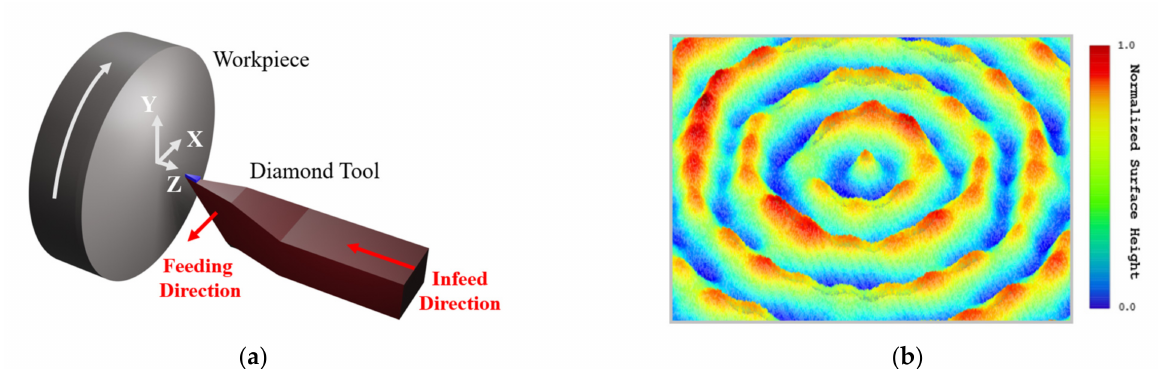
Figure 1. ( a ) On-axis diamond turning visualization. The workpiece is rotated at high speeds, and the diamond tool is brought into contact with the workpiece surface. Material is removed along a spiral track. The tool is moved along the feeding direction to traverse the surface; ( b ) Demonstration of surface error from on-axis diamond marks. Each concentric mark is the result of a material removal path taken by the diamond tool. Note the surface variation comparing each track (most notably the variations in depth). The combined structure of these TMs yields specific impacts optical